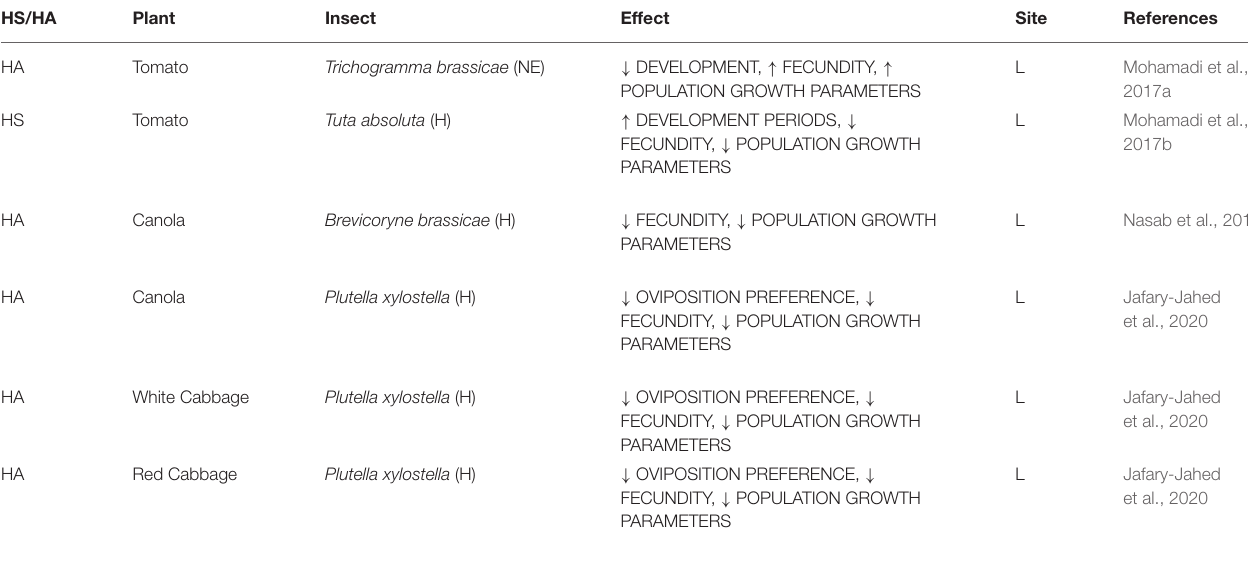
TABLE 1B | Examples of wide use of humic substances (HS) and humic acid (HA) affecting the behavioral response of insects and other natural enemies of different